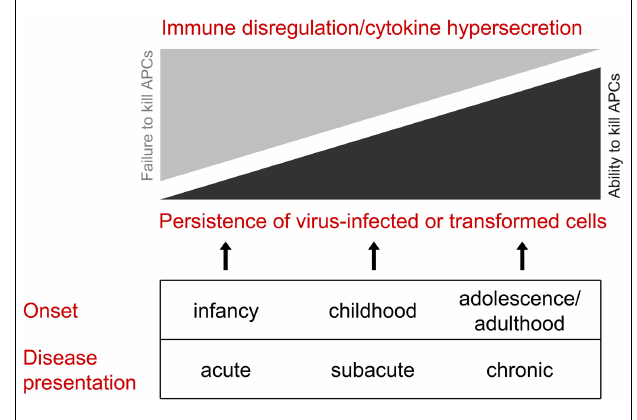
FIGURE 1 |All of the clinical presentations of perforin deficiency (including the failure to deliver active perforin into the immune synapse) result from failed killing of an antigen-presenting cell . Early in life, the clinical manifestations are more likely to reflect cytokine hypersecretion due to chronic stimulation of CD4 and CD8 CTLs and NK cells, resulting in disordered immune hemostasis affected both the lymphoid and myeloid compartments. Later in life, hyper-inflammatory presentations are less likely, and the clinical scenario is more likely to reflect failure to clear dangerous target cells, particularly virus-infected cells and neoplastic